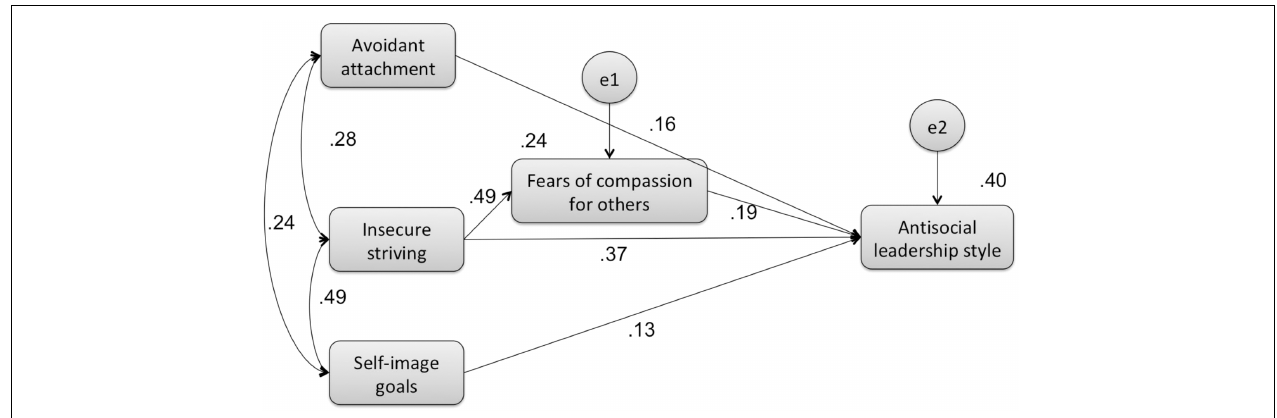
FIGURE 1 | Results of the adjusted model for the mediation path analysis showing the relationships among fears of compassion for others, avoidant attachment, insecure striving, self-image goals, and antisocial leadership style.